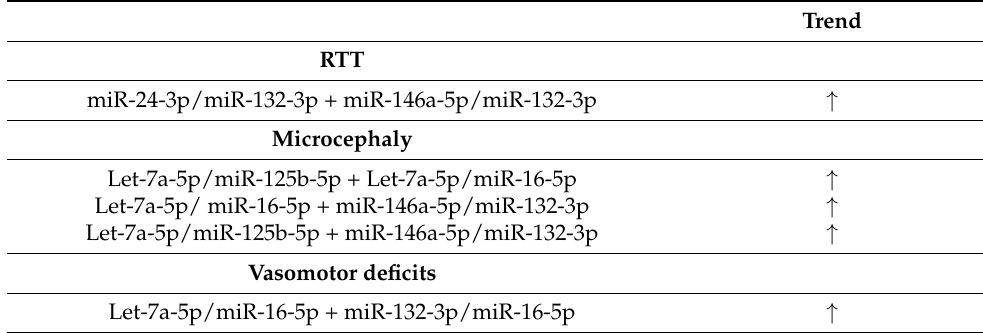
Table 7. Summary of potential circulating miRNA biomarkers for RTT screening and